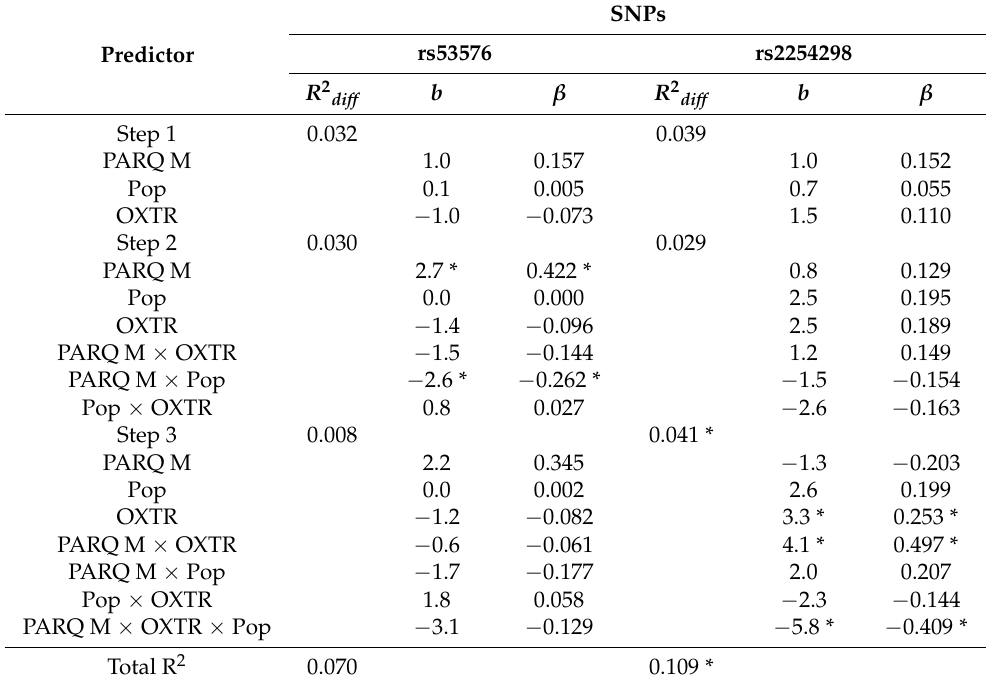
Table 2. Hierarchical multiple regression analyses predicting depression (BDI) from remembered maternal rejection, OXTR gene polymorphism, population and their interaction.